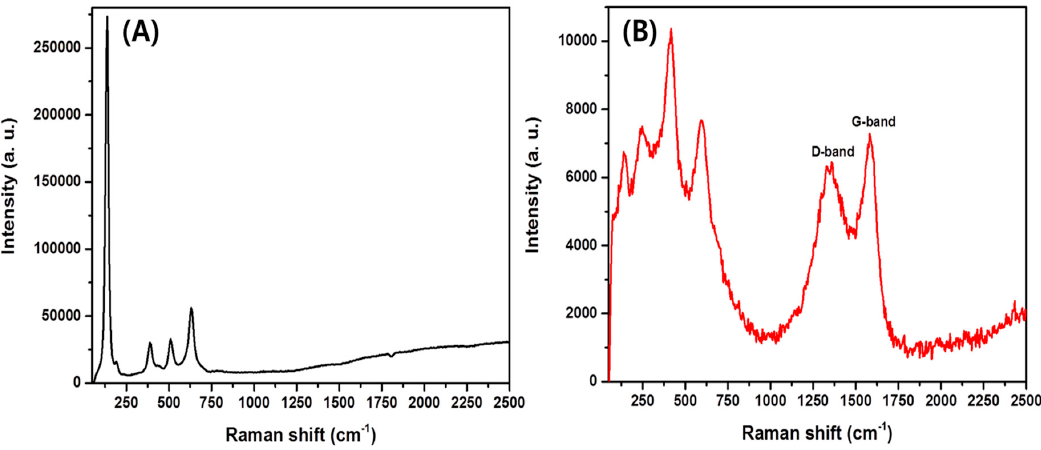
Figure 6. Raman spectra of TiO 2 NFs ( A ) and TiO 2 -carbon NFs ( B ).